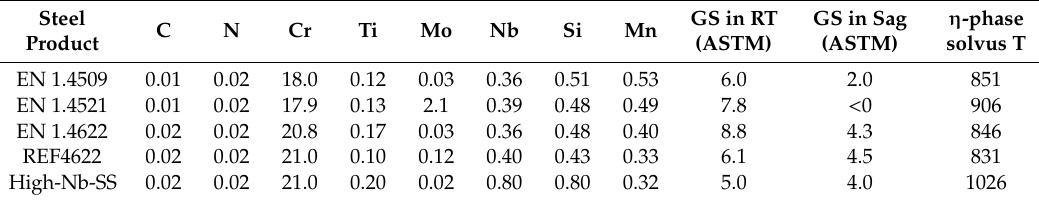
Figure 7. Deflection measured and standard deviation after sag test at 850 °C, 950 °C and 1050 °C for the trial steel and conventional ferritic stainless steels typically used in high-temperature applications. Table 1. Chemical compositions, grain size (GS) at room temperature (RT) and after Sag test in 950 ◦ C for 100 h, and simulated solvus temperatures of η -phase in the High-Nb-SS trial and reference steels, and existing steels used in high temperature applications produced by Outokumpu